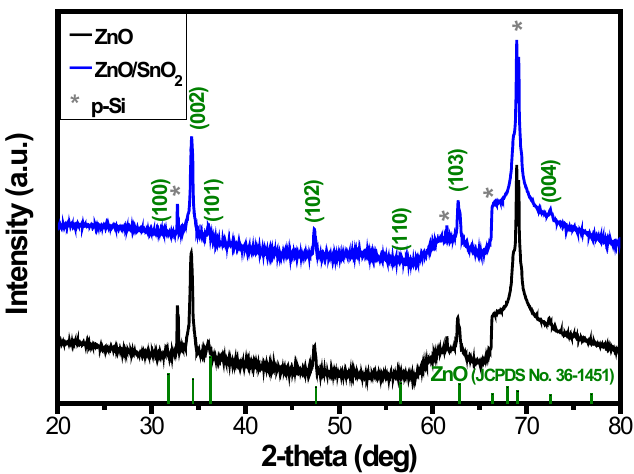
Figure 4. The XRD patterns of ZnO NRs and ZnO/SnO 2 NRs. To evaluate the performance of ZnO/a-SnO 2 core–shell NRs UV PDs, I–V characteris- tics and time-domain photoresponse values were measured. Figure 5a–c shows the I–V characteristics of the ZnO/a-SnO 2 PD (red line) and the bare ZnO PD (black line) under dark, 365 nm UV light, and 254 nm UV light conditions, respectively. There are several key figures of merit (FOMs) that can be used to analyze the performance of PDs, such as the photocurrent and responsivity. The photocurrent is defined as ∆ I = I light − I dark , where I light is the current under light illumination and I dark is the current under dark conditions. The photocurrent values of the ZnO/a-SnO 2 NRs PD were 8.57 × 10 − 6 A and 4.86 × 10 − 6 A under 365 nm UV light and 254 nm UV light illumination at − 5 V, respectively, whereas those of the bare ZnO NRs PD were 2.75 × 10 − 6 A and 3.11 × 10 − 6 A. Another key FOM for PDs, i.e., responsivity R, is expressed using the following equation: R = ∆ I/PS. Here, P is the incident light intensity and S is the effective illuminated area. The responsivities of the fabricated devices were calculated based on the measured photocurrents and the effective illuminated area, 1.5 × 1.5 cm 2 . Under 365 nm UV light illumination, the responsivity of the ZnO/a-SnO 2 PD was 6.24 × 10 − 3 A/W at − 5 V, whereas the ZnO PD had a value of 2 × 10 − 3 A/W at − 5 V. Under 254 nm UV light, the responsivity of the ZnO/a-SnO 2 PD was 5.4 × 10 − 3 A/W at − 5 V, whereas the ZnO PD showed a value of 3.46 × 10 − 3 A/W at − 5 V. The responsivity was improved by 3.1 and 1.6 times under 365 nm and 254 nm UV light illumination, respectively, by using the a-SnO 2 shell layer. To investigate the enhancement of the photoresponse speed when the a-SnO 2 shell layer was applied to the ZnO NRs PDs, the time-domain photoresponses were measured at a fixed bias condition of − 5 V, as shown in Figure 5c,d. The response speed for incident light can be expressed by the rise time, T r (or fall time, T f ), which is defined as the time required for the photocurrent to increase from 10% to 90% of its maximum current (or decrease from 90% to 10%). Under 365 nm UV light, the ZnO/a-SnO 2 PD exhibited a faster rise time, i.e., 0.19 s, compared to that of the ZnO PD (4.93 s), while the fall time remained stable (about 0.08 s), as shown in Figure S1a. Under 254 nm UV light, the ZnO/a-SnO 2 PD also exhibited again remained substantially stable at about 0.08 s, as shown in Figure S1b. To compare the performances of our a-SnO/ZnO NRs-based device with previously reported ZnO- and SnO 2 -based PDs, we summarized the key FOMs in Table S1. As demonstrated, the ZnO/a-SnO 2 PD showed a dramatically improved performance as a UV PD in comparison with the ZnO PD. The rise and fall times, which are critical shortcomings of ZnO PDs, were considerably improved by 26 times and 16 times,